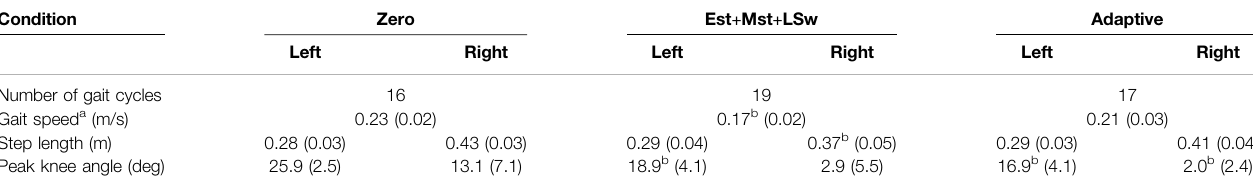
TABLE 3 | Spatiotemporal and knee angle outcomes during exoskeleton walking in participant with CP.